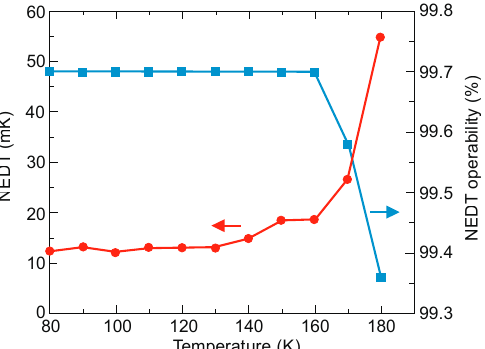
Figure 75. NEDT and operability versus temperature for 24 μ m pitch MWIR 640 × 512 nBn InAs/InAsSb FPA.